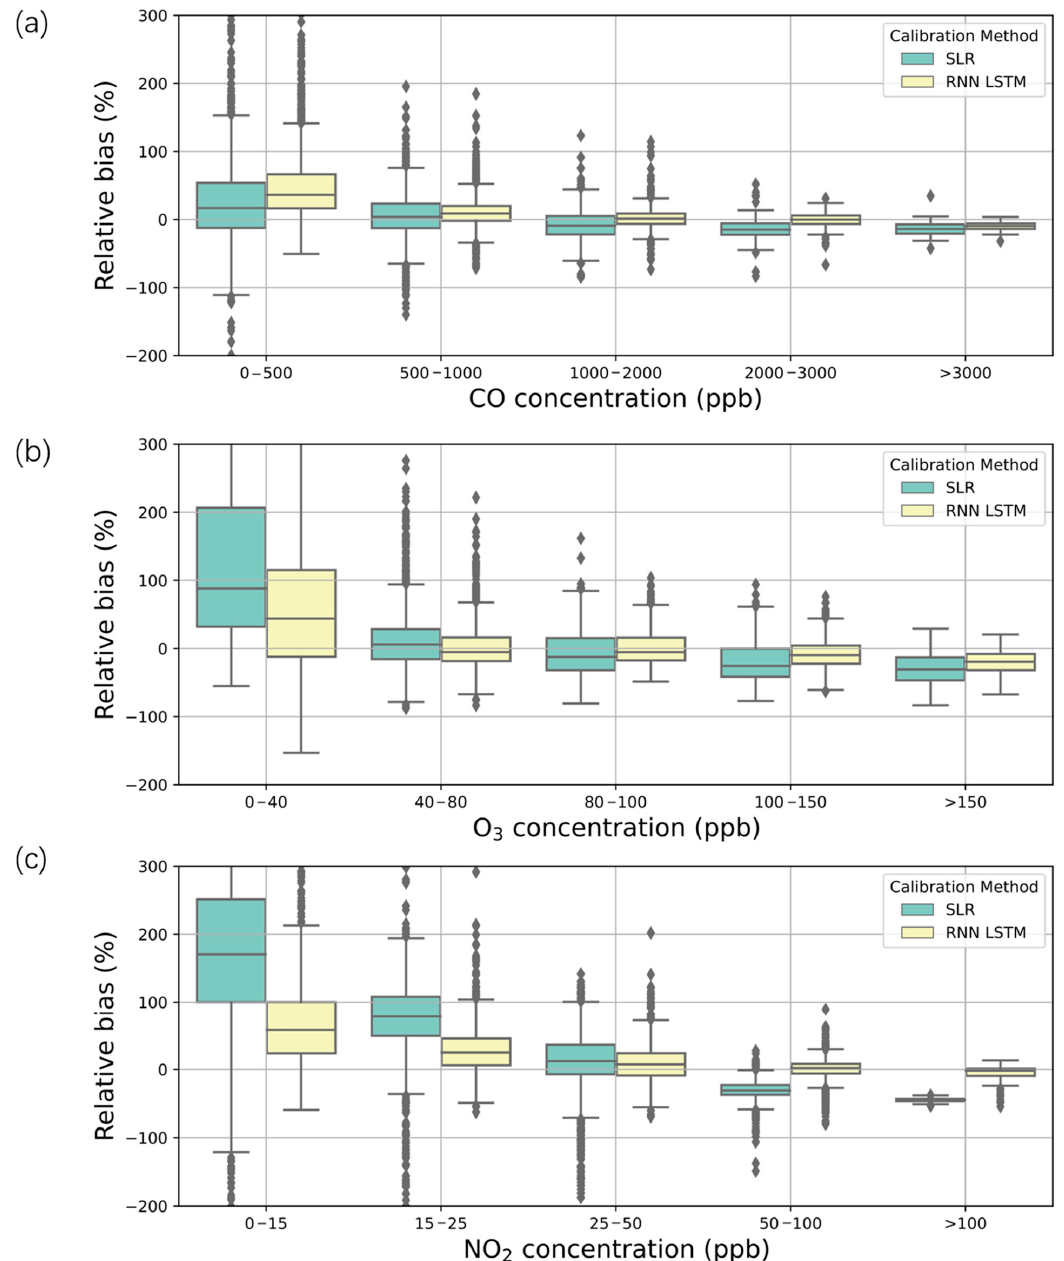
Figure 5. Comparison of the relative biases between SLR/LSTM calibrated sensors and MEE at different concentration ranges. Boxes of different colors represent different correction methods. The lines within the boxes represent the medians of data. The interquartile range (IQR) is the range of the boxes and indicates the difference from the 25th to the 75th percentile. Whiskers represent values within 1.5 times the IQR, and dots are values outside 1.5 times the IQR. ( a ) CO, ( b ) O 3 , and ( c ) NO 2 .